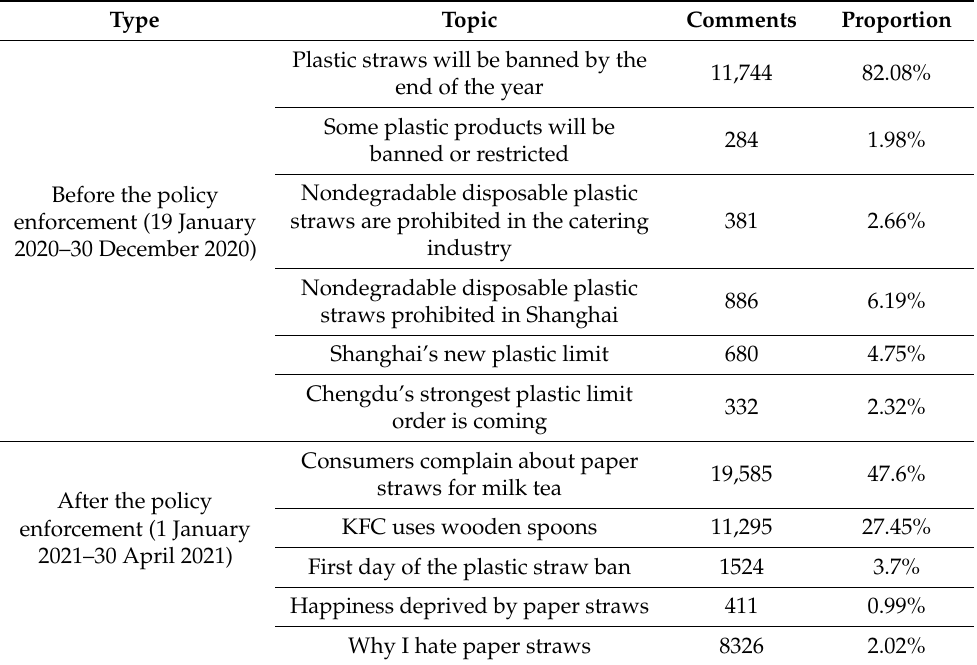
Table 2. Weibo topics and comments after